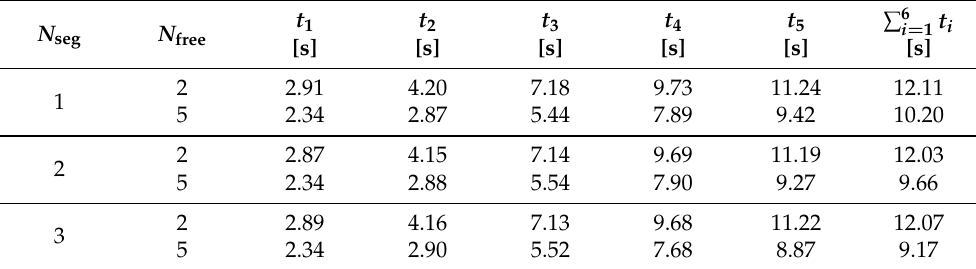
Table 1. Resulting travel times on segments and total travel times. Simulations were performed for different numbers of optimization parameters N free ∈ { 2,5 } , and different numbers of seg- ments N seg ∈ { 1,2,3 } , whose geometry was taken into account when calculating the solution for the current segment.